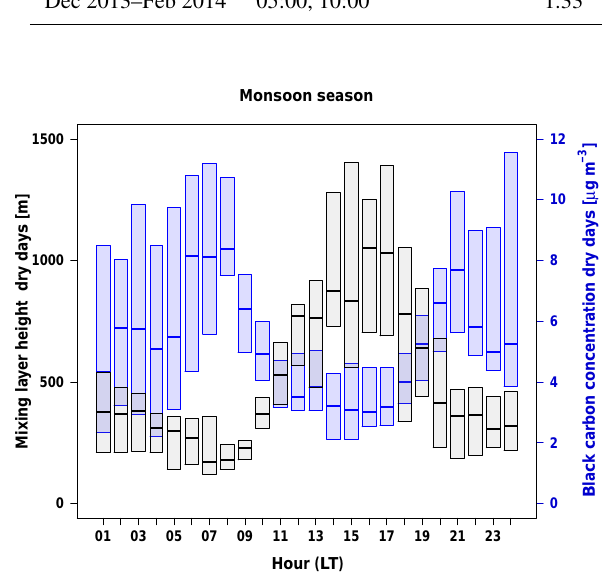
Figure 10. Diurnal cycle of the MLH (grey) and the BC concentra- tion (blue) for only dry days as a boxplot (showing the median, the upper and lower quantile) for the monsoon season (June–September 2013) at the Bode